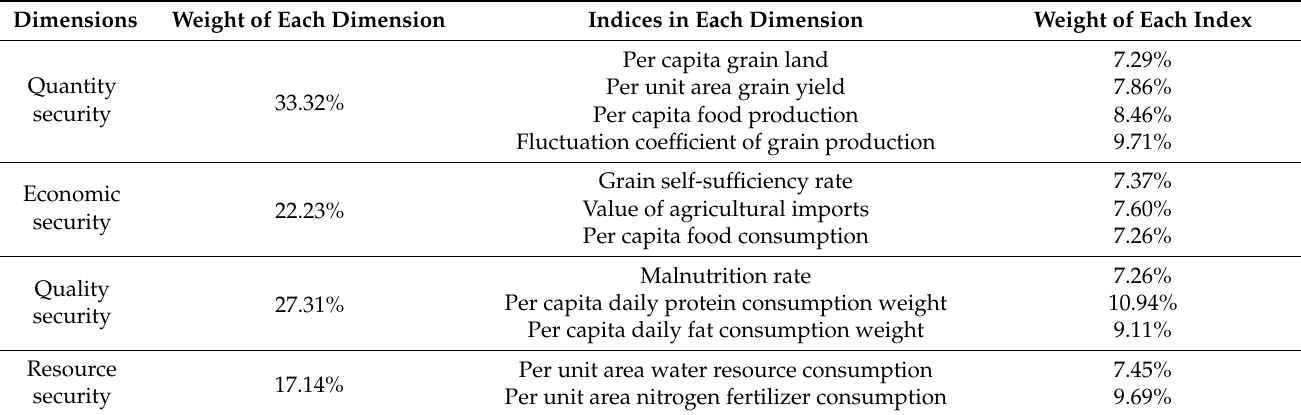
Table 9. Weights of four dimensions and weights of indices in each